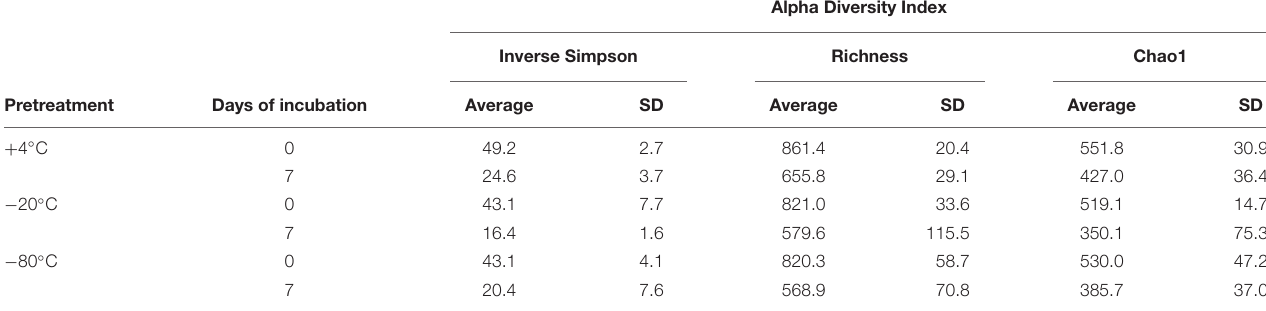
TABLE 1 | Alpha diversity indices.